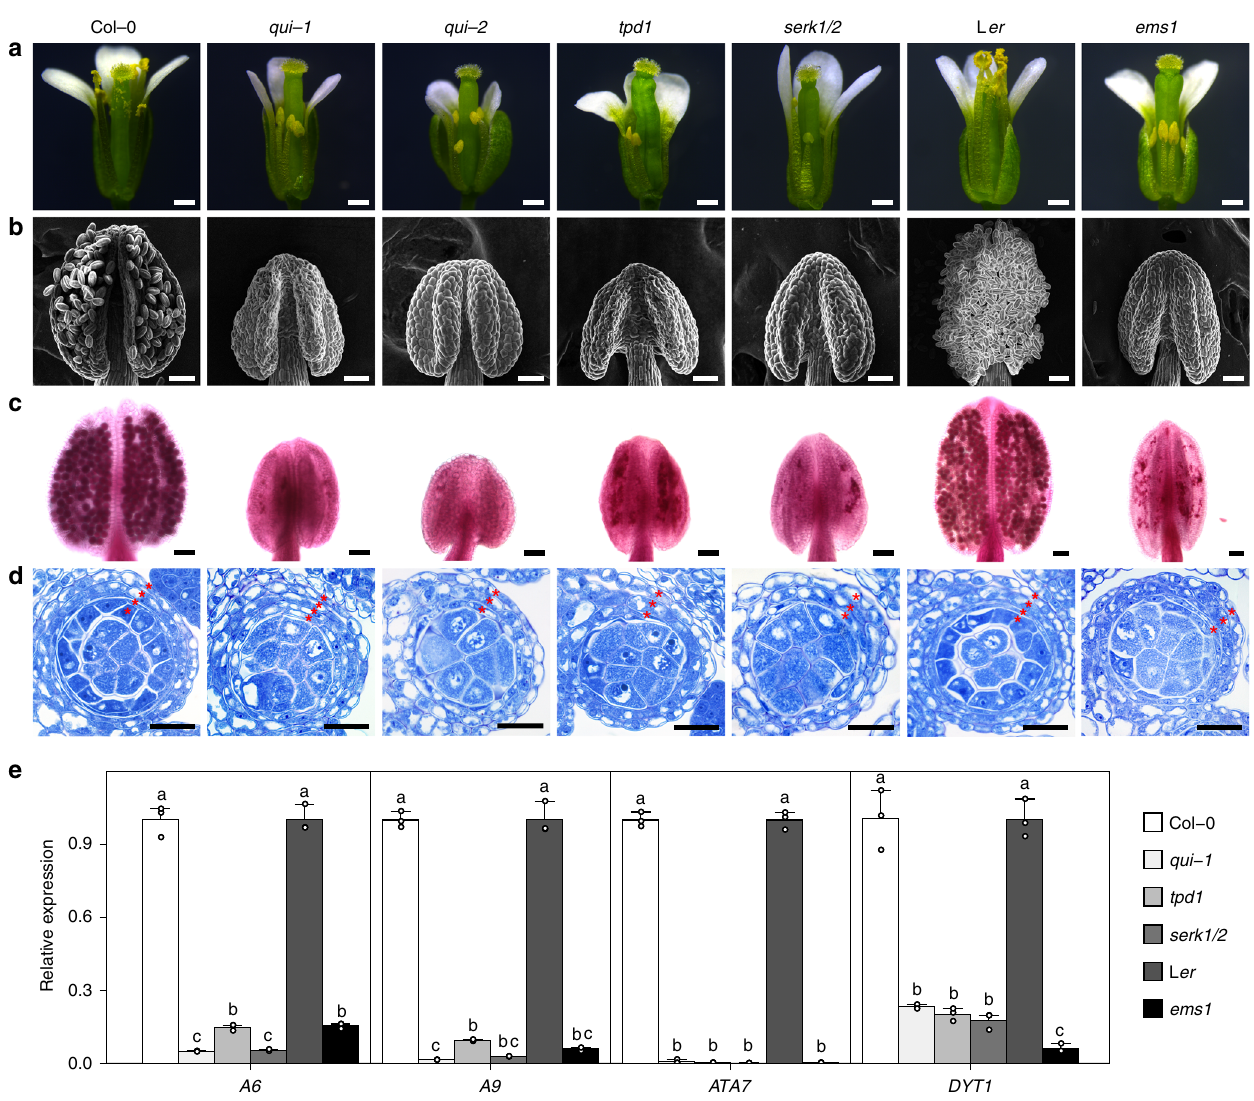
Fig. 5 bes1-1 bzr1-1 beh1-1 beh3-1 beh4-1 (qui-1) , bes1-c1 bzr1-1 beh1-1 beh3-1 beh4-c1 (qui-2) , tpd1 , serk1 serk2 , or ems1 show similar anther developmental defects. a Floral phenotypes of Col-0, qui-1 , qui-2 , tpd1 , serk1/2 , L er and ems1 . The qui-1 and qui-2 display shortened fi laments similar to tpd1 , serk1 serk2 , and ems1